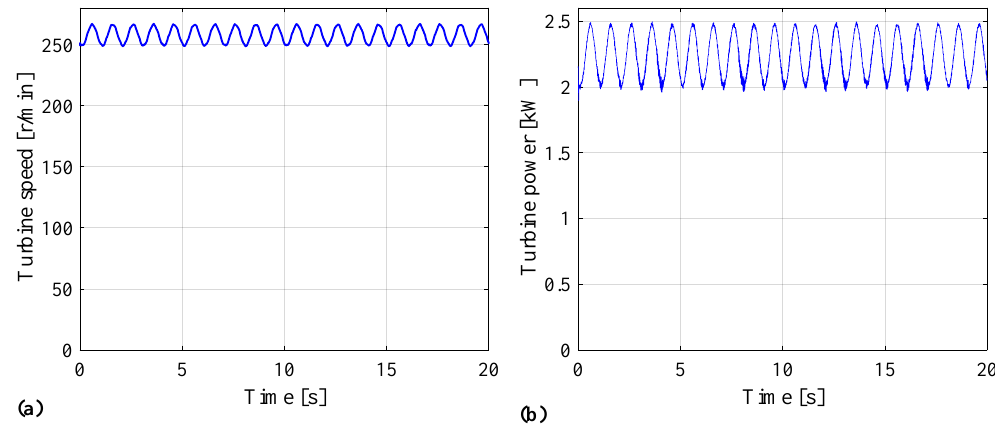
Figure 27. Measured ( a ) turbine speed with a frequency of 1 Hz and ( b ) the turbine power response.